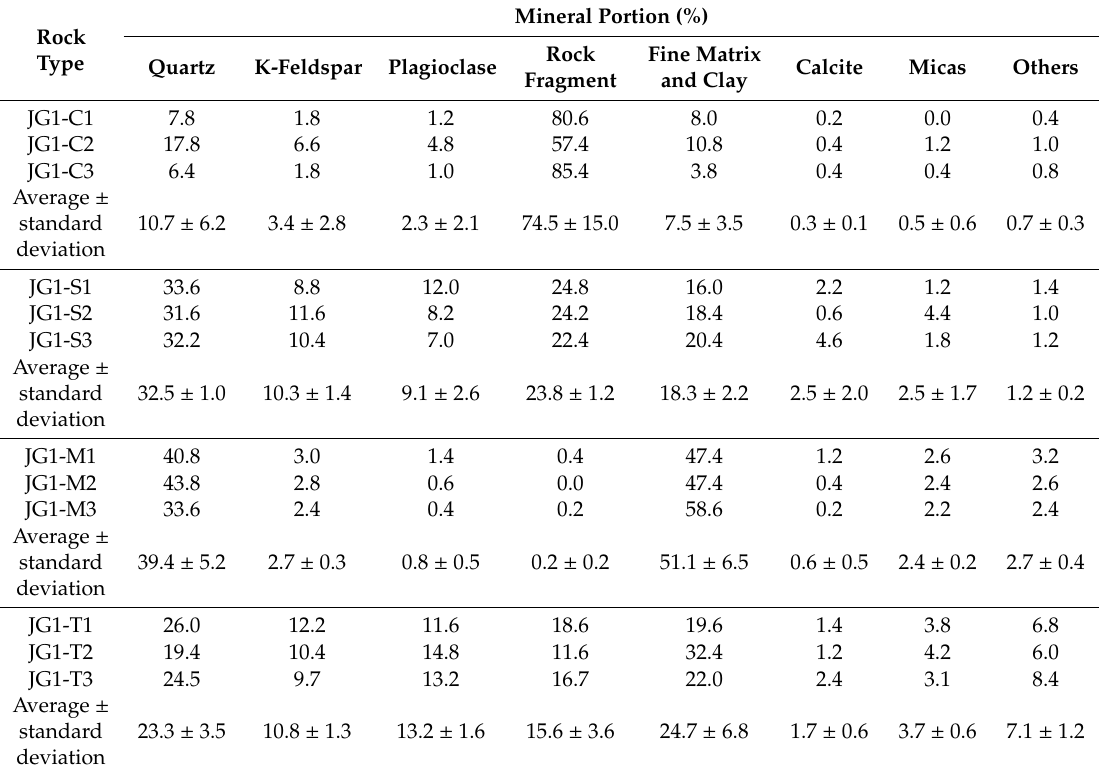
Table 1. Petrographic detrital modal analysis of the rock cores.